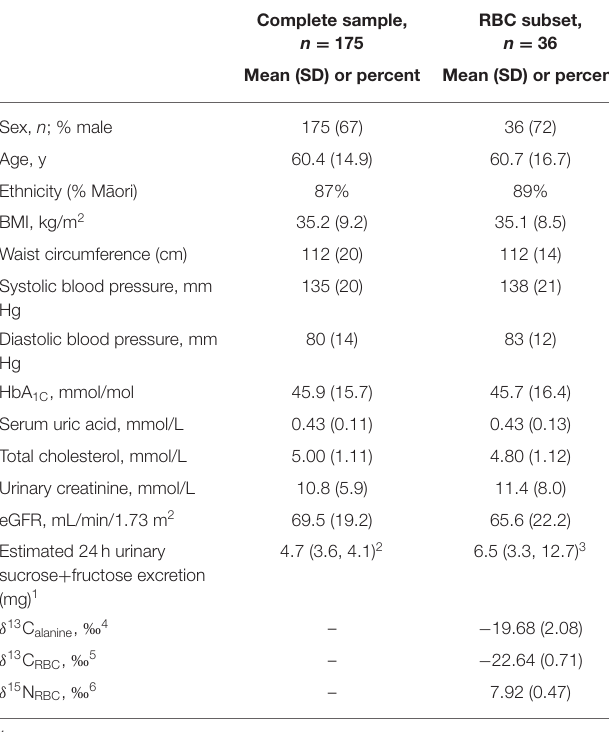
( Figure 2 ). δ 13 C RBC was not correlated with any sugars intake variables. Estimated 24 h urinary sugars excretion